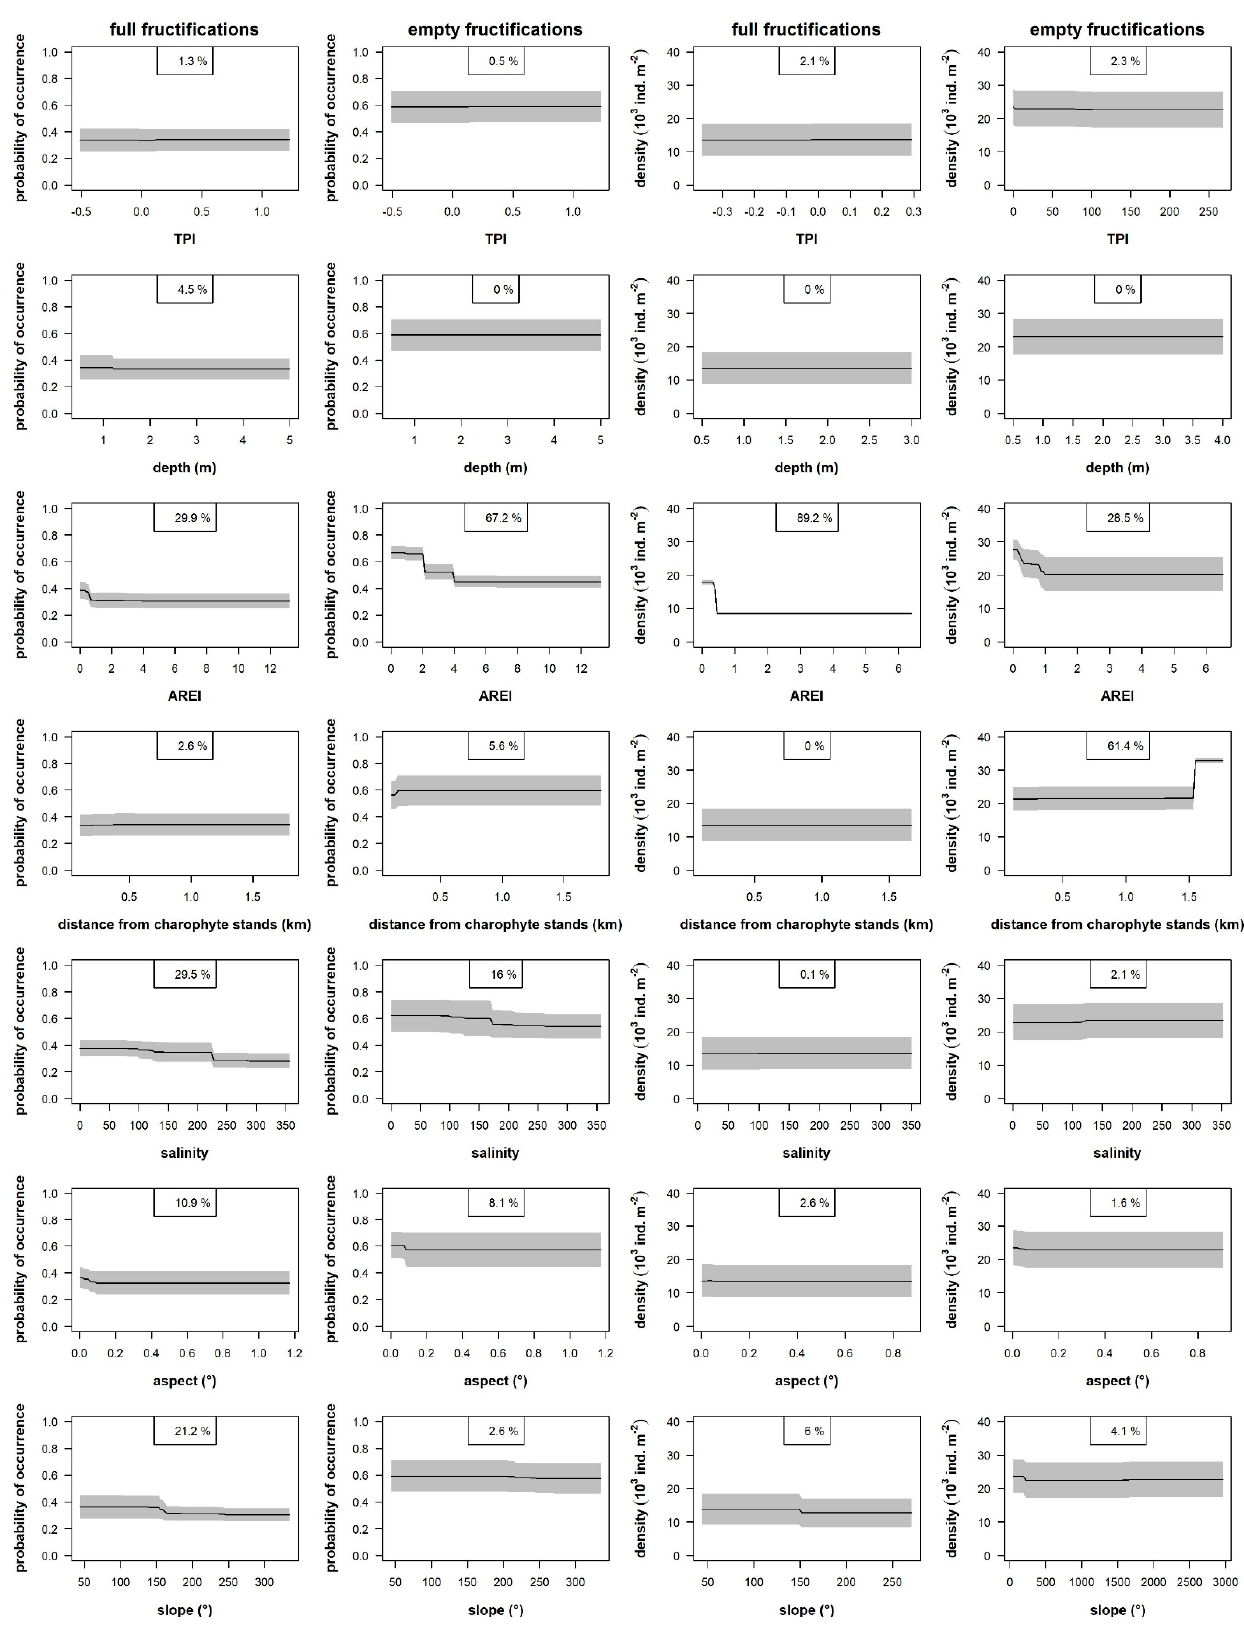
Figure 6. The partial dependence curves between the occurrence and density of full (viable) charophyte fructifications and empty charophyte fructifications and the environmental factors. The relative importance of environmental factors is provided in the top legend for each